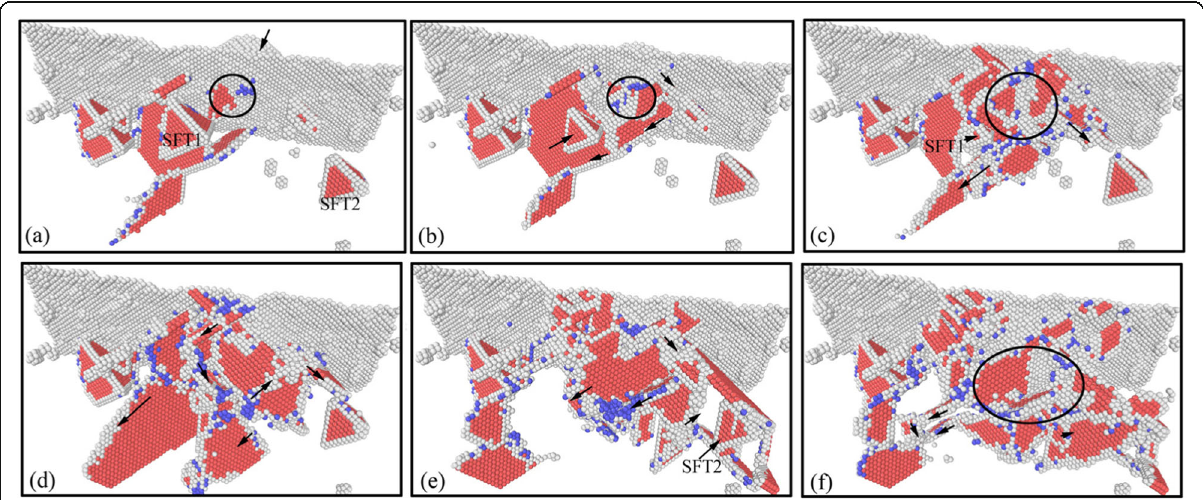
Fig. 7 Subsurface dislocation defects evolution in loading process of nano-indentation (color online). The corresponding indentation depths of a – f are 0 nm, 0.5 nm, 1 nm, 2 nm, 3 nm, and 4 nm,